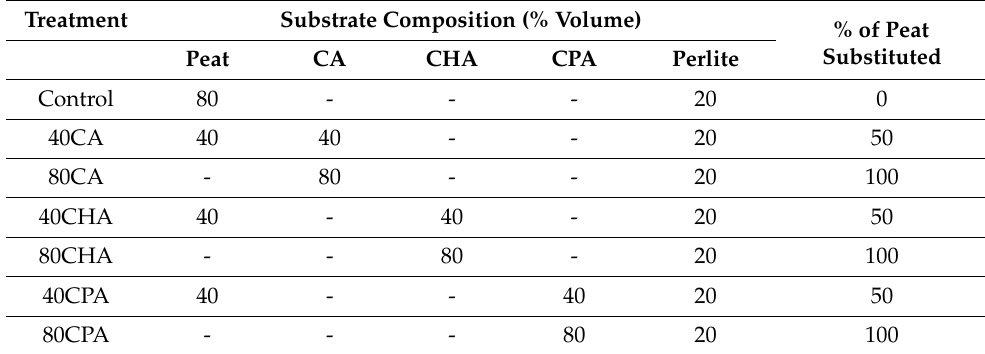
Table 1. Composition of the substrates for each